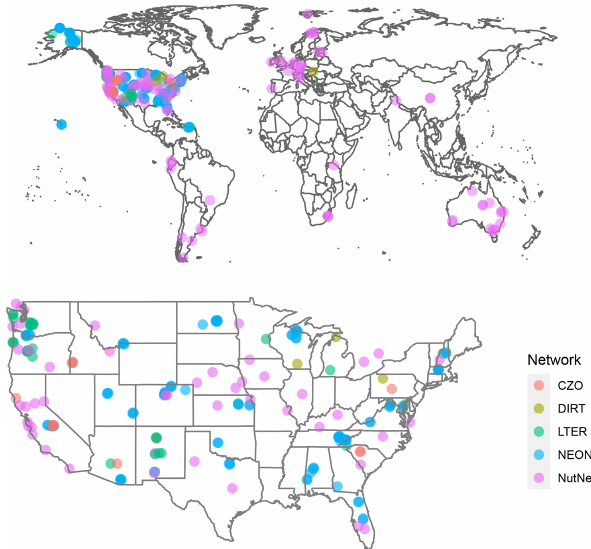
Figure 4. Spatial distribution of study locations representing five research networks in SoDaH globally and in the contiguous USA.